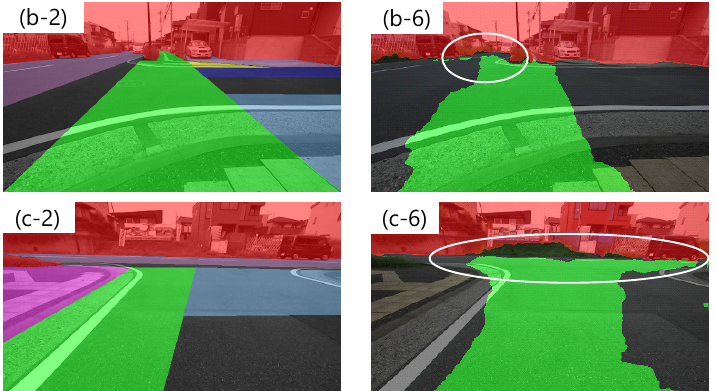
Figure 14. Examples of outputting recommended areas on non-recommended areas. ( b-2 )–( c-6 ) are enlarged images of Figure